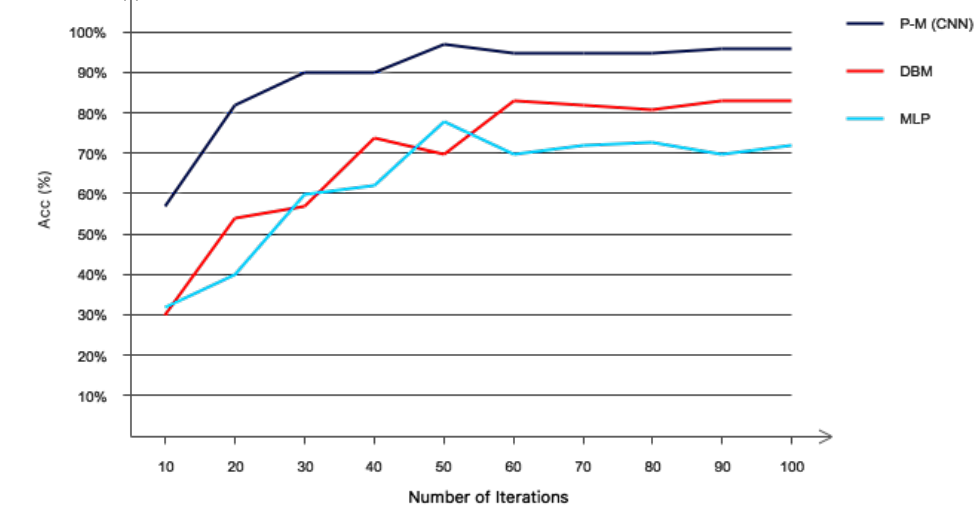
Figure 15. Comparison of the proposed method with common methods.